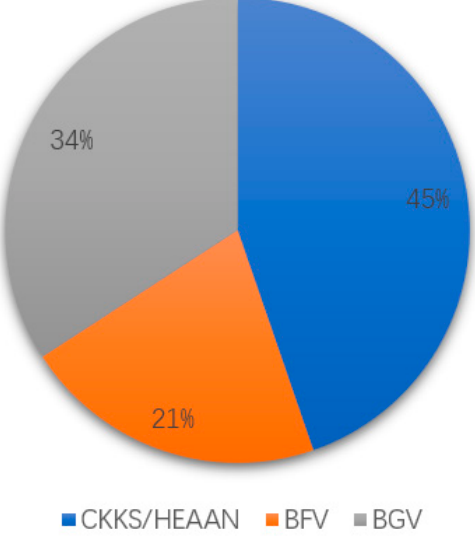
Figure 12. Proportion of homomorphic encryption schemes used in different documents.